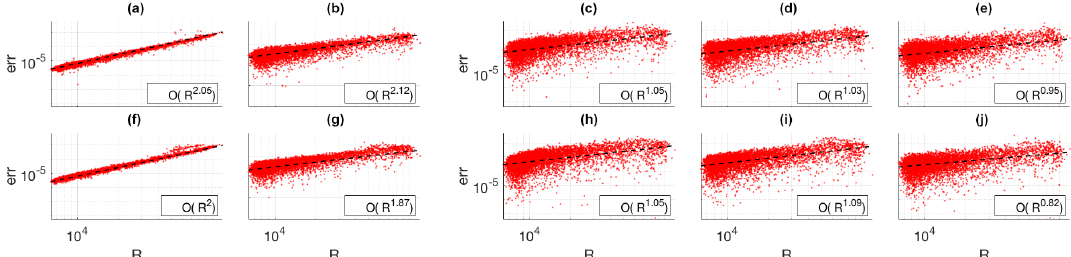
Figure A5. (a–e) Discretization errors vs. mesh resolution for the averaged-gradient approach used in UFEMISM for, from left to right, f x , f y , f xx , f xy , and f yy . (f–j) The same for the least-squares approach from Syrakos et al. (2017). Log-linear fits have been made to all errors, with the order of convergence shown in the legends. Both approaches show very similar absolute errors and rates of convergence.